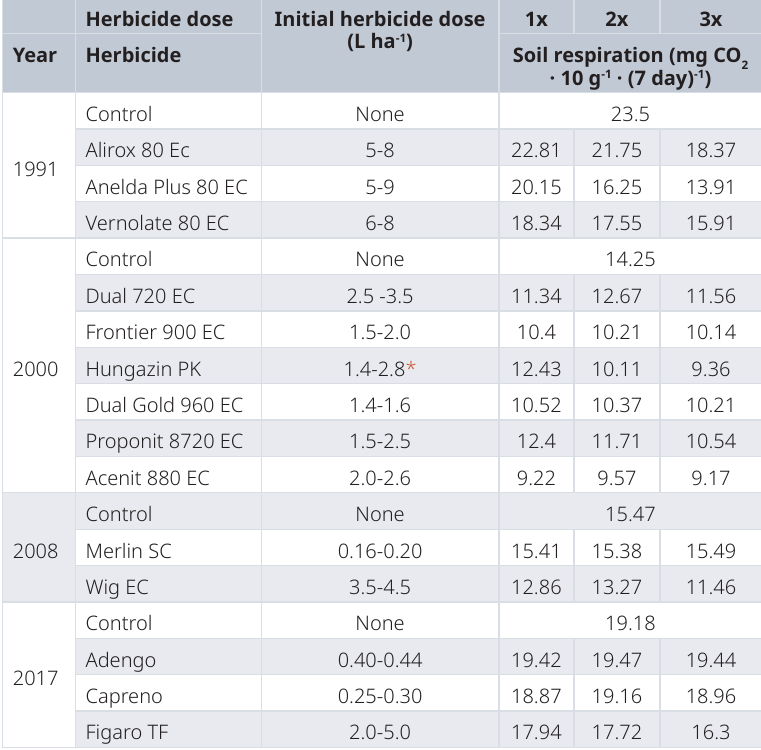
Table 1. Herbicides’ doses and soil respiration measured.